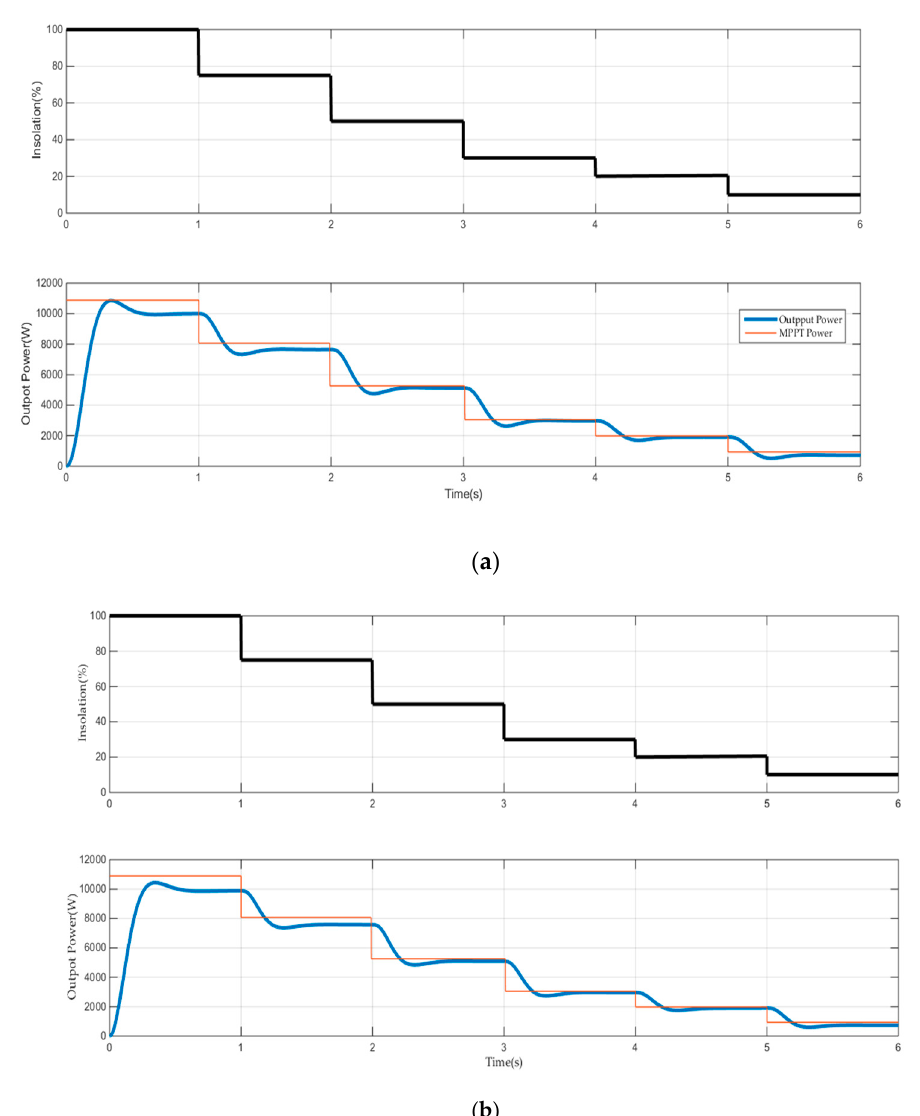
Figure 12. The maximum power point (MPP) power and output power at step insolation variations for the ( a ) MPC controller and ( b ) PI current controller with